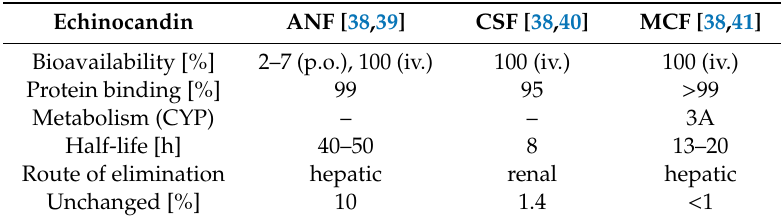
Table 2. Pharmacological properties of